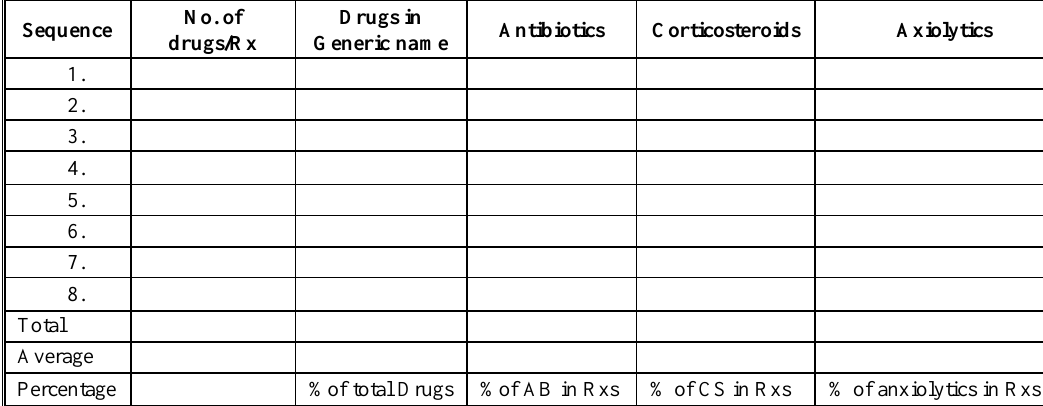
Table 1: Prescribing indicators